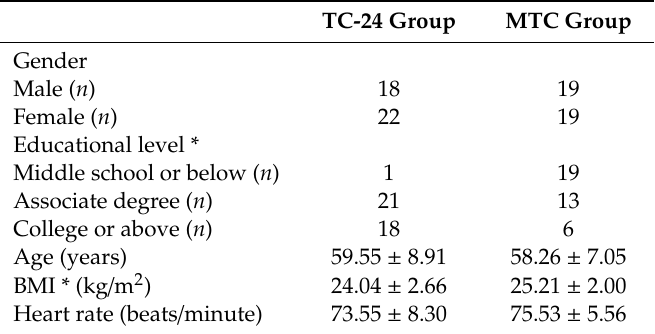
Table 1. Summaries of baseline variables in both experimental arms ( n = 78).